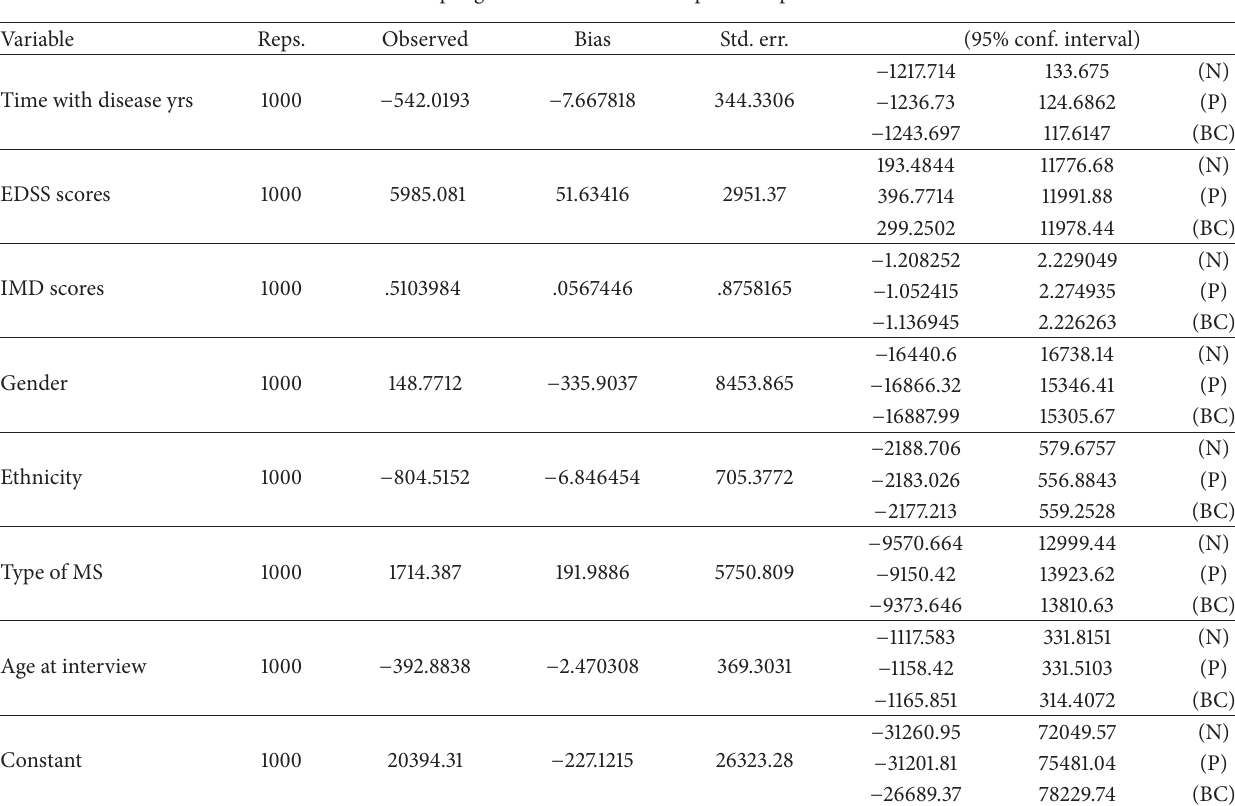
Table 4: Bootstrap regression with additional potential predictor